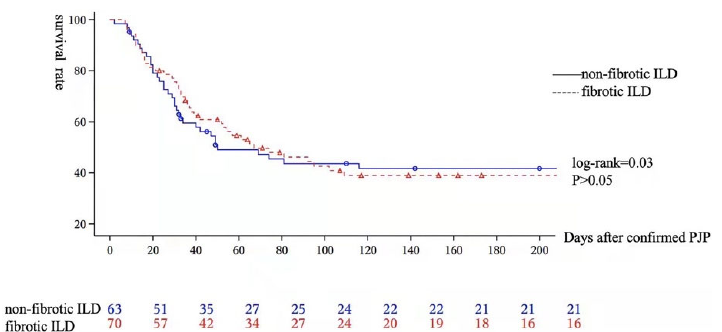
Figure 4. Kaplan–Meier survival analysis for all enrolled ILD-PJP patients. The all-cause mortality is similar between the FILD-PJP patients and the non-FILD-PJP patients (log-rank = 0.03, p > 0.5). Table 5. The differences between FILD ‐ PJP group and non ‐ FILD ‐ PJP group.